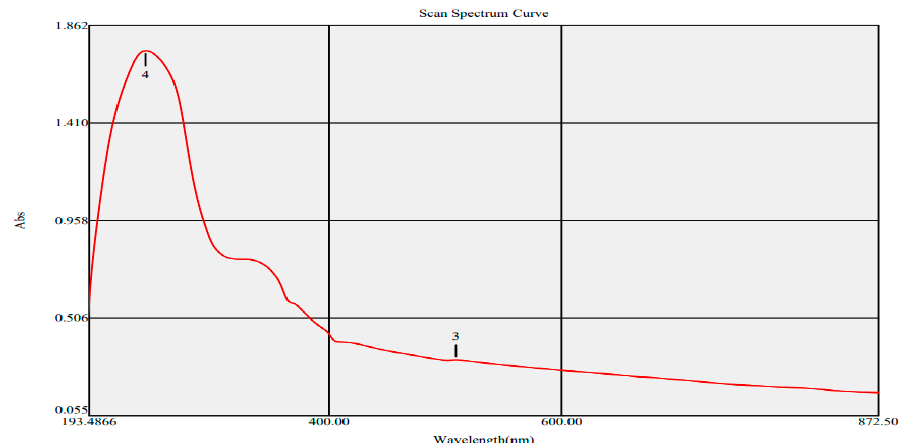
Figure 2. Diagrammatic illustration of ZnO-NPs biosynthesis.